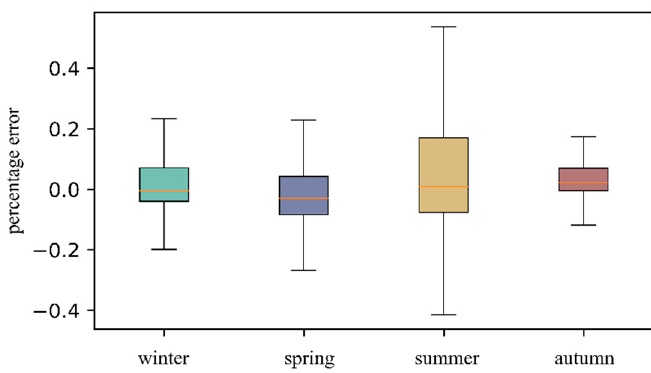
Figure 9. GA–PSO–CNN forecast error in different seasons.